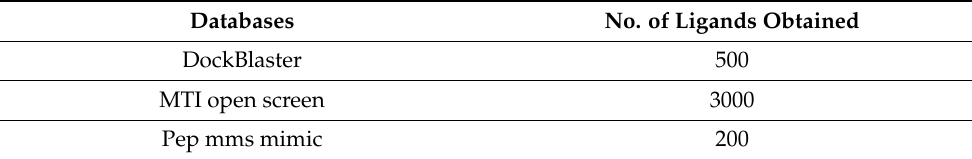
Table 4. Number of ligands obtained in structure-based virtual screening.